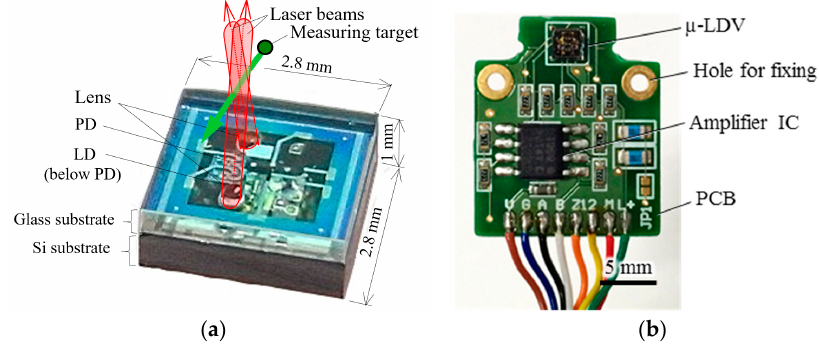
Figure 4. The developed slip sensor called μ -LDV: ( a ) A photo of the μ -LDV with a schematic of laser beam irradiation. The cross volume of laser beams is measurable volume of slip velocity; ( b ) A photo of the μ -LDV installed onto PCB with fixing through-hole, wiring, and pre-amplifier circuit.